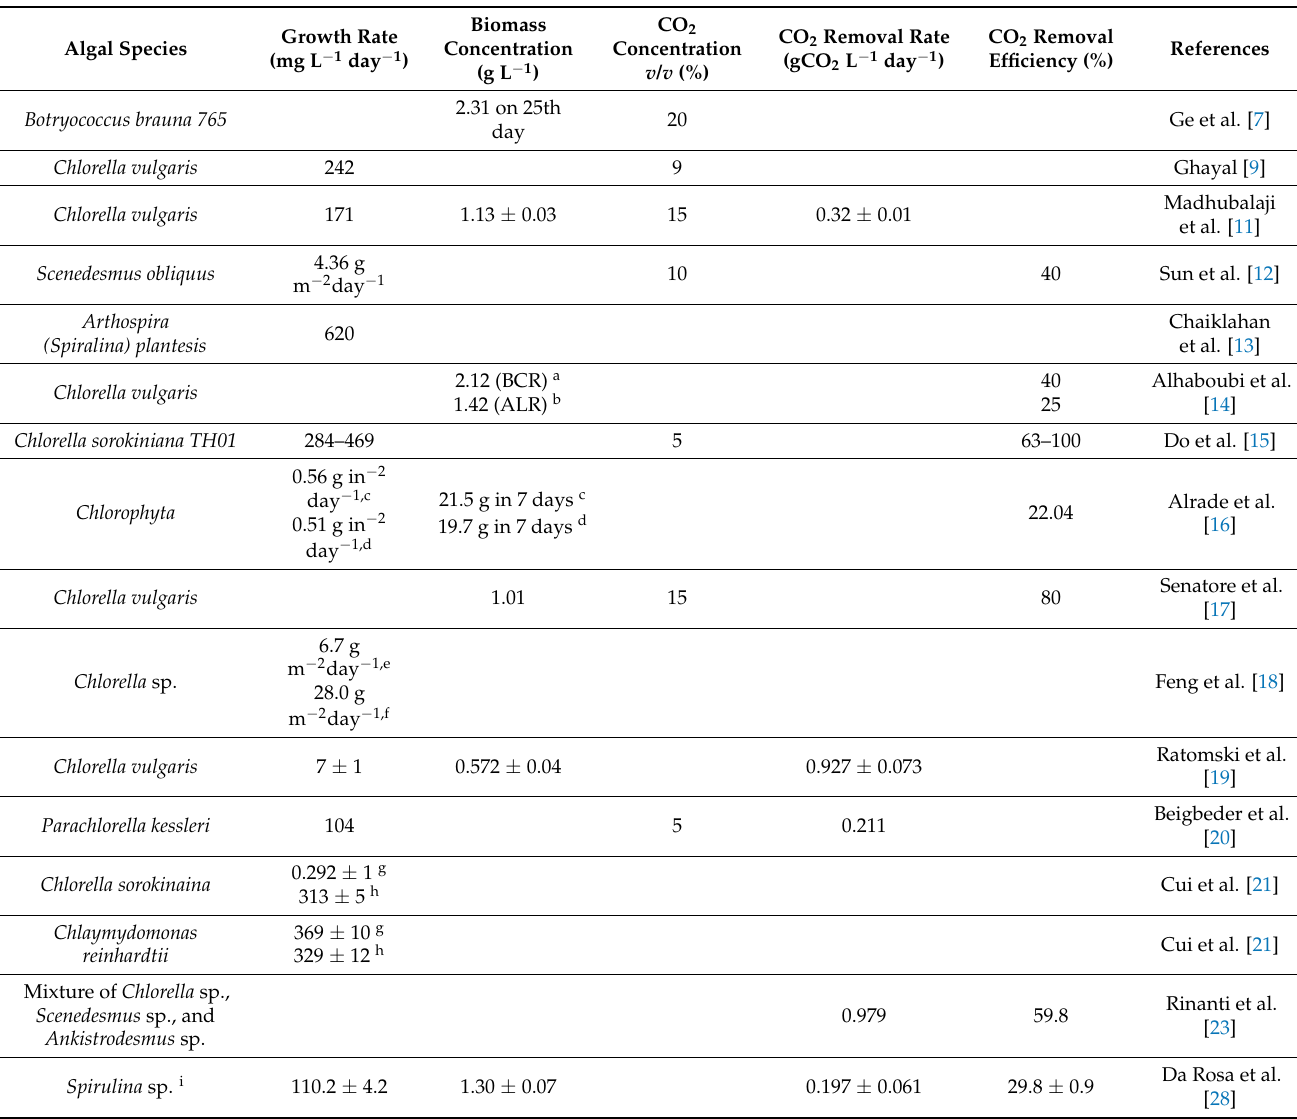
Table 1. Summary of various Algal species and their respective growth rates, yields, and CO 2 removal rates at specific CO 2